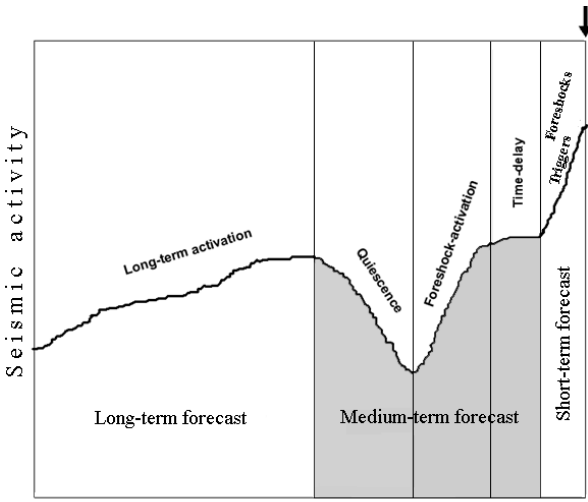
Fig. 12. Main phases of seismic activity prior to earthquake and earthquake